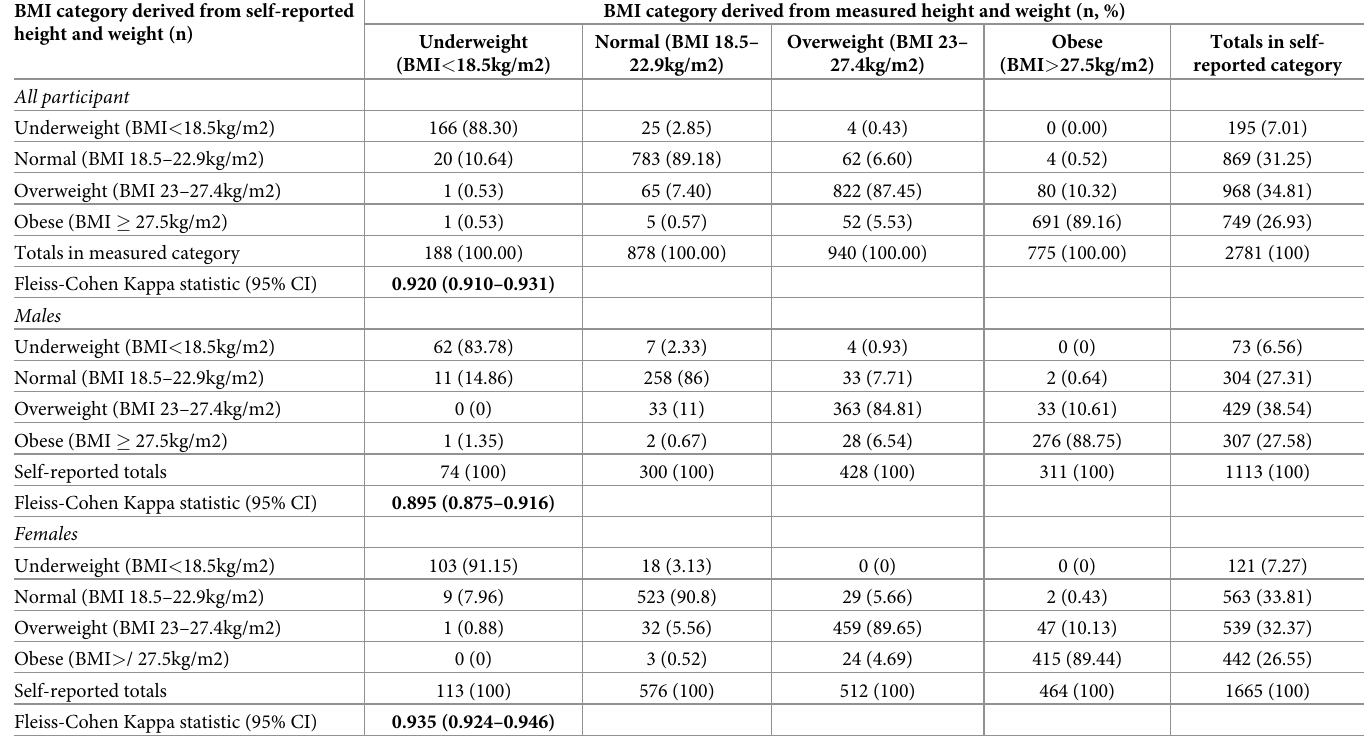
Table 3. Comparison of BMI categories derived from self-reported and measured height and weight values in all participants, and when with stratification by